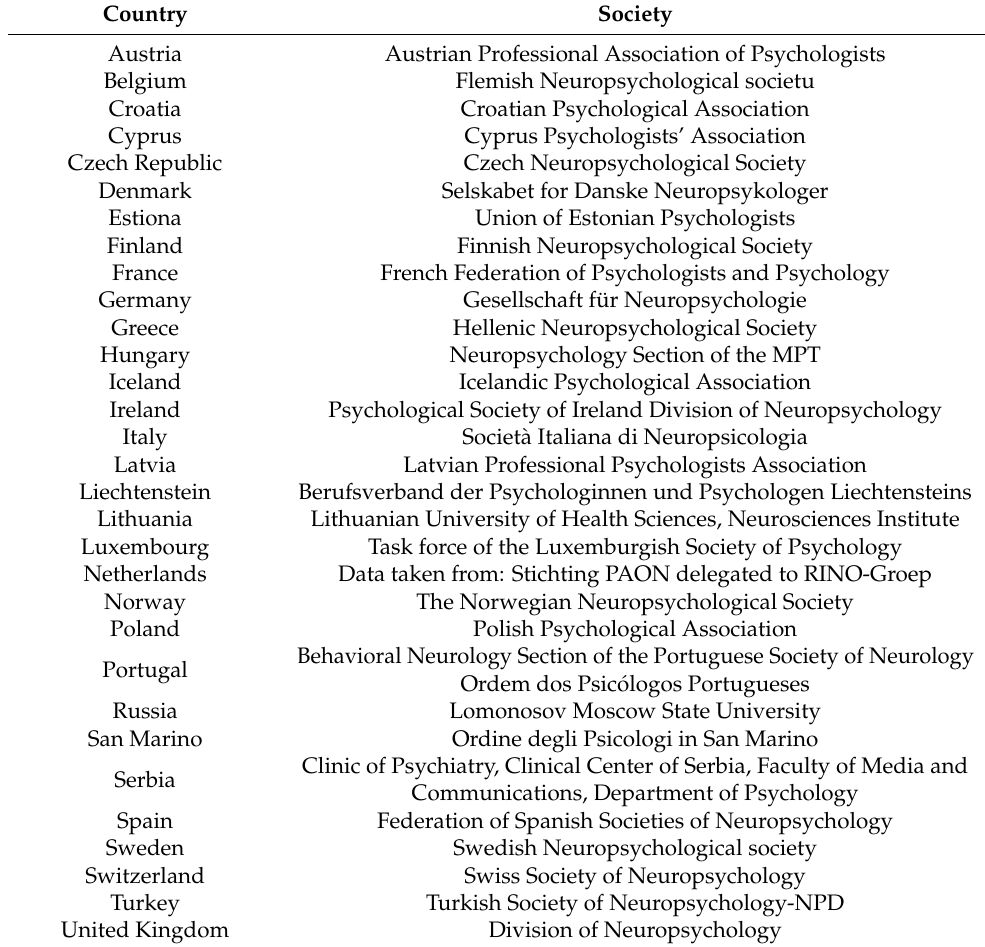
Table 1. Information about the societies of the